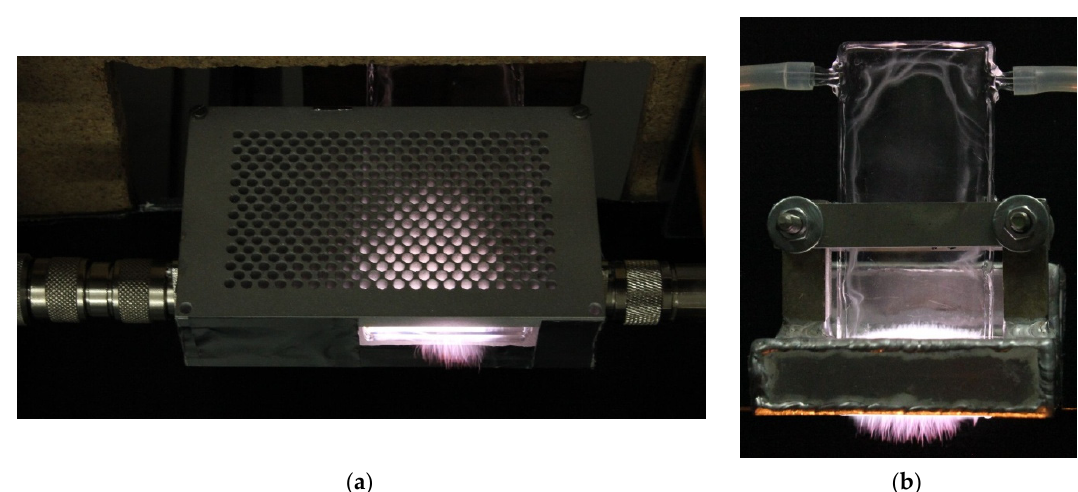
Figure 20. Plasma visualization for: ( a ) stripline-supplied closed configuration and ( b ) waveguide-supplied configuration. Microwave power entering the device 250 W, argon flow rate 15 L/min.